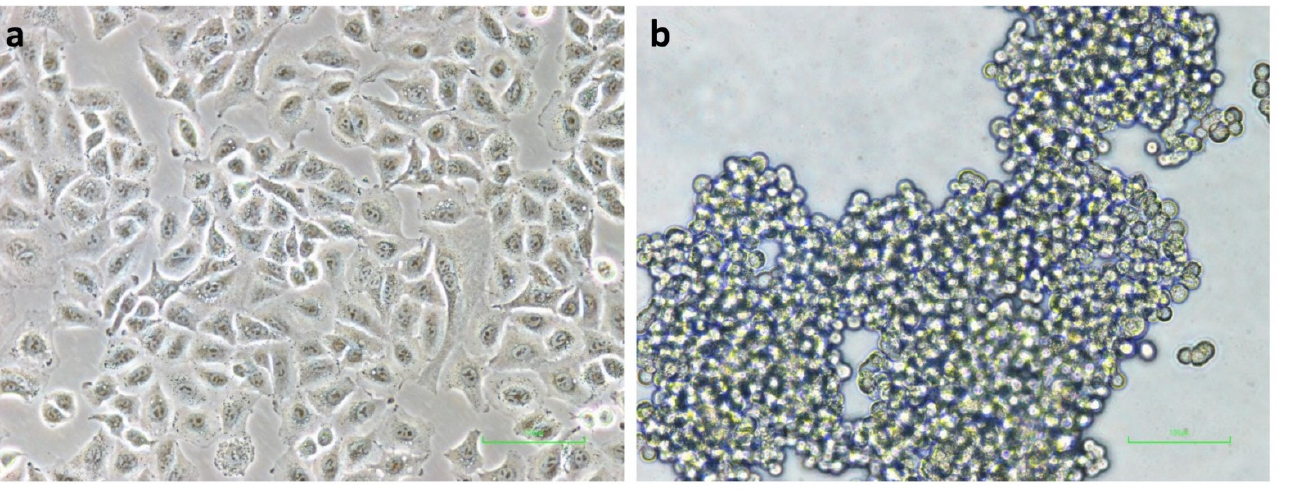
Figure 3. Morphology of ( a ) A549 attached cells cultured under adherent condition and ( b ) A549 floating cells cultured under non-adherent condition. Original magnification of ×200. Scale bar is 100 μ m.